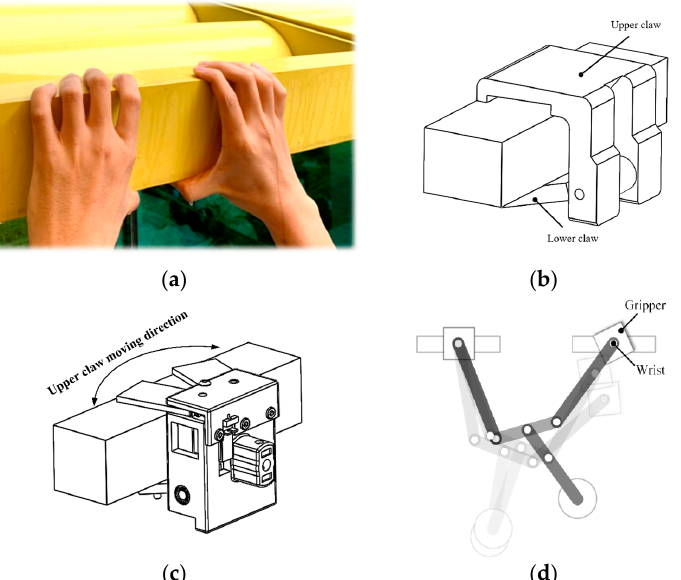
Figure 4. Conceptual design of gripper mechanism: ( a ) athlete supporting body weight on a ledge; ( b ) simplified design; ( c ) proposed design; ( d ) wrist posture deviation.